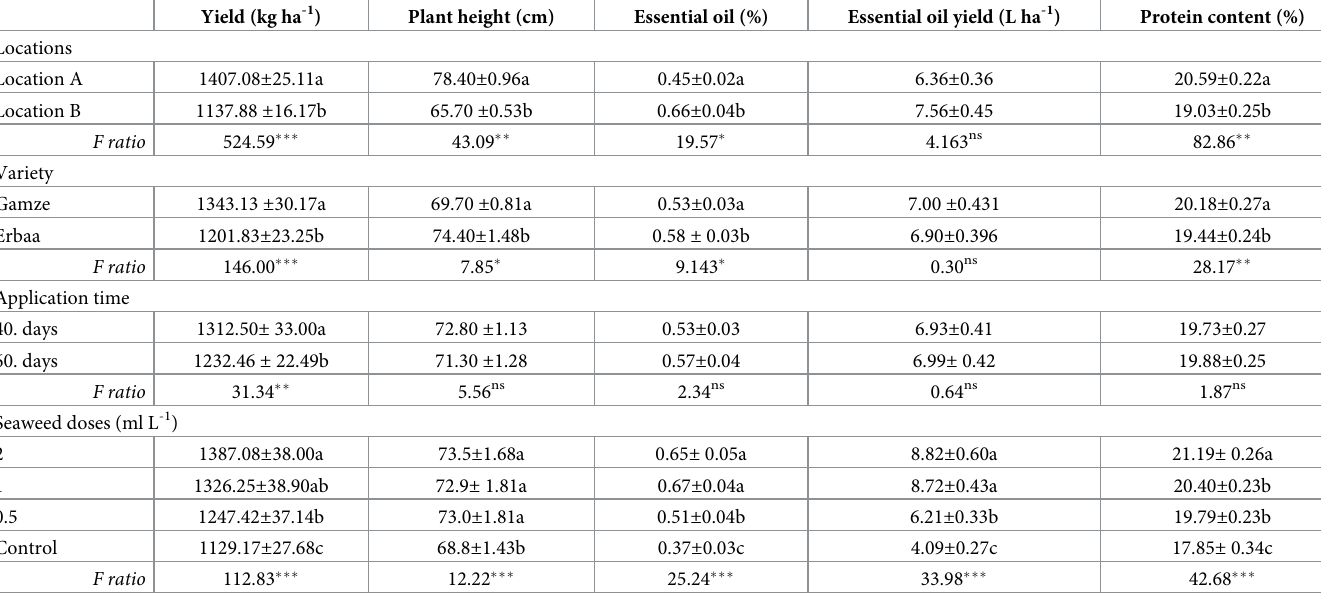
Table 3. Effects of seaweed applied at different times and doses at two different locations ( ± standard